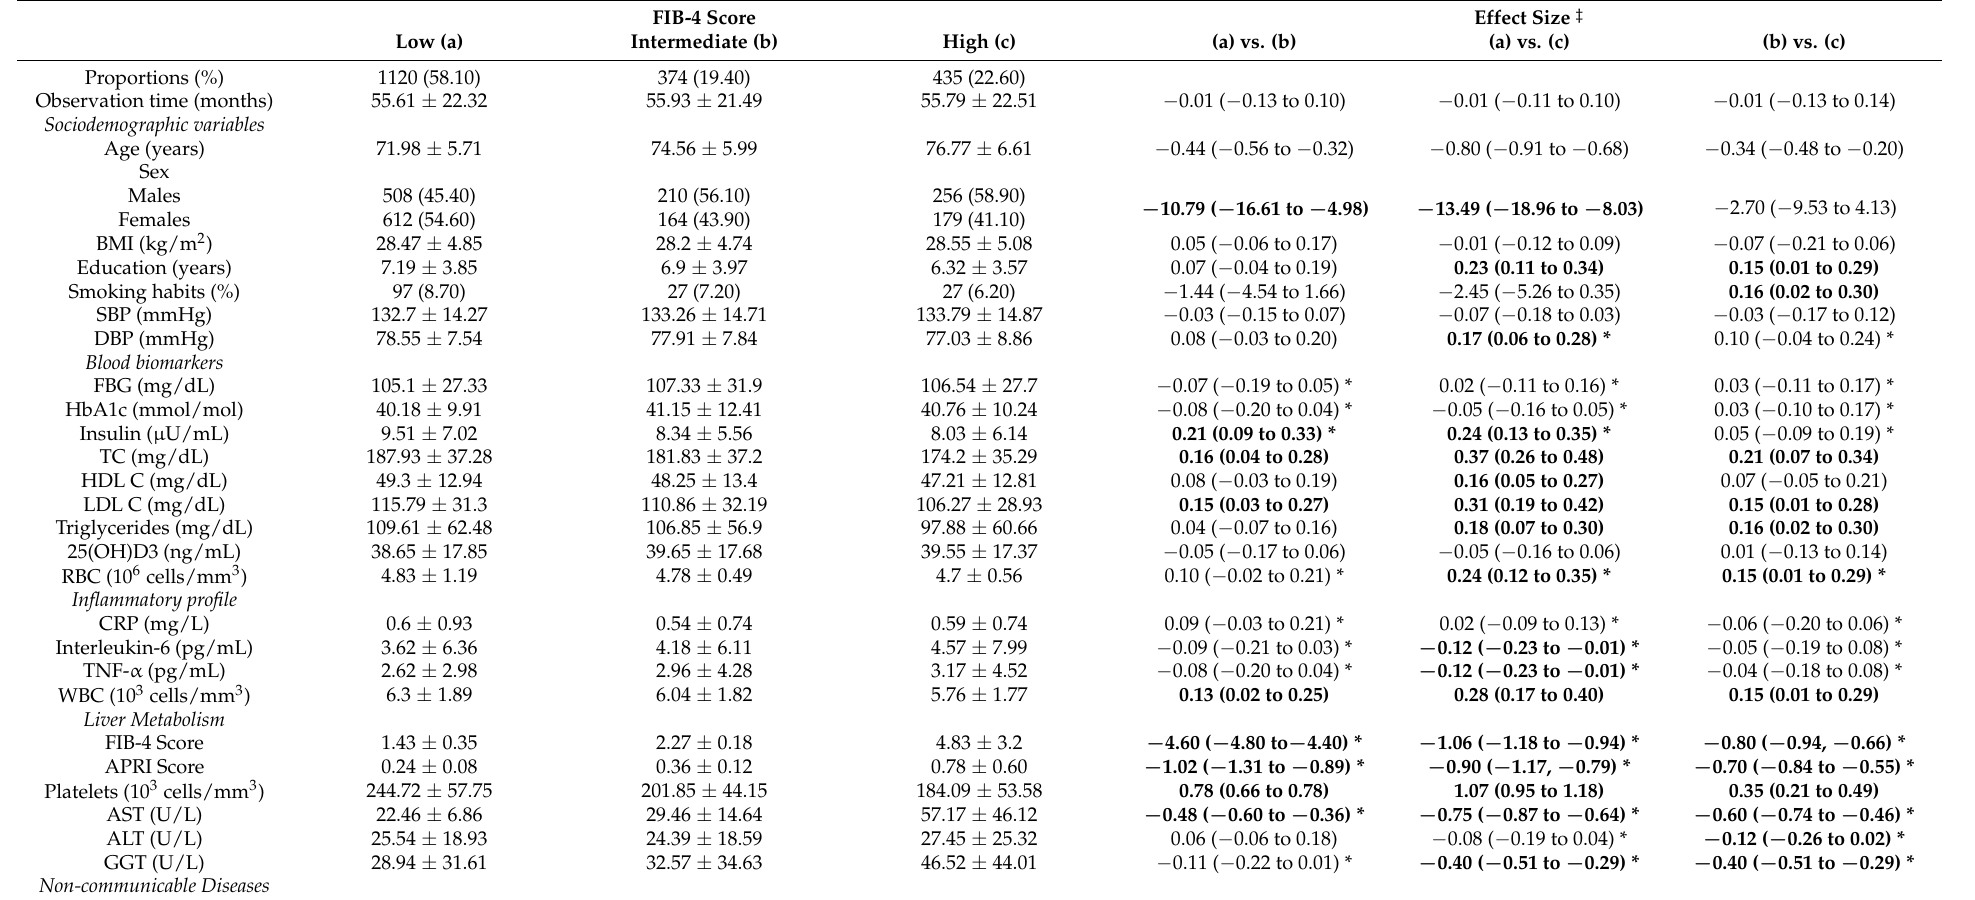
Table 1. Baseline sociodemographic and clinical characteristics of the study population according to fibrosis-4 (FIB-4) score. The Salus in Apulia Study (N =